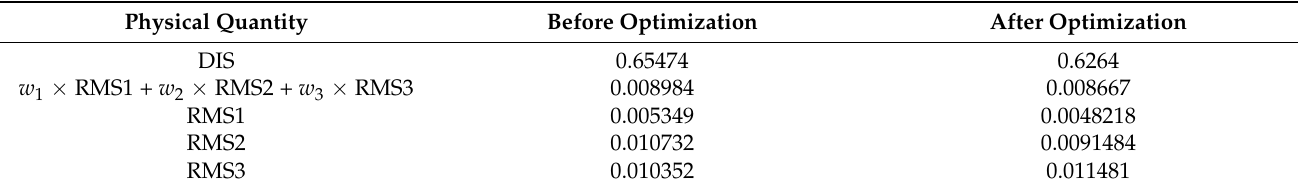
Table 10. Comparison of key parameters before and after